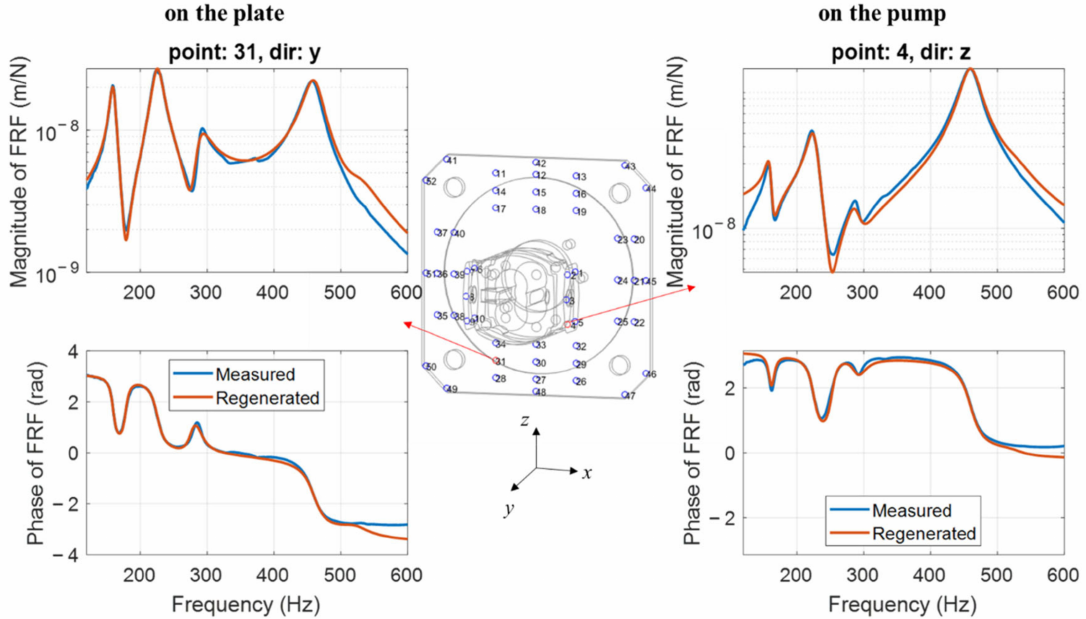
Figure 5. Comparison between the measured FRFs (blue line) and the regenerated FRFs based on the modal parameters (red